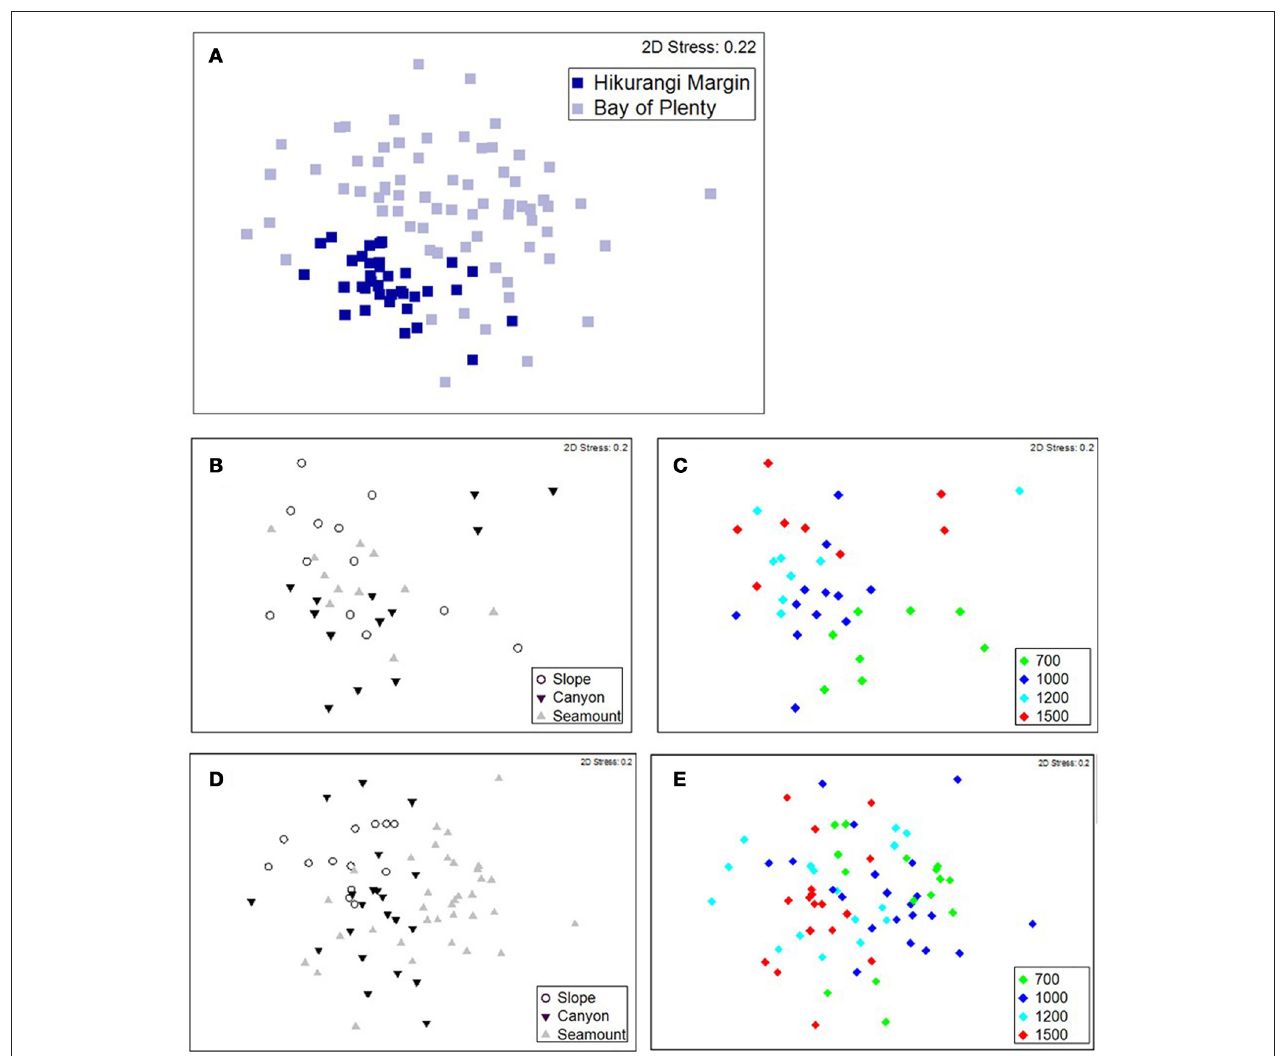
FIGURE 2 | MDS ordination plots showing megafaunal community similarity among samples coded for (A) region, (B) habitat, and (C) depth for the Hikurangi Margin region, and (D) habitat and (E) depth for the Bay of Plenty